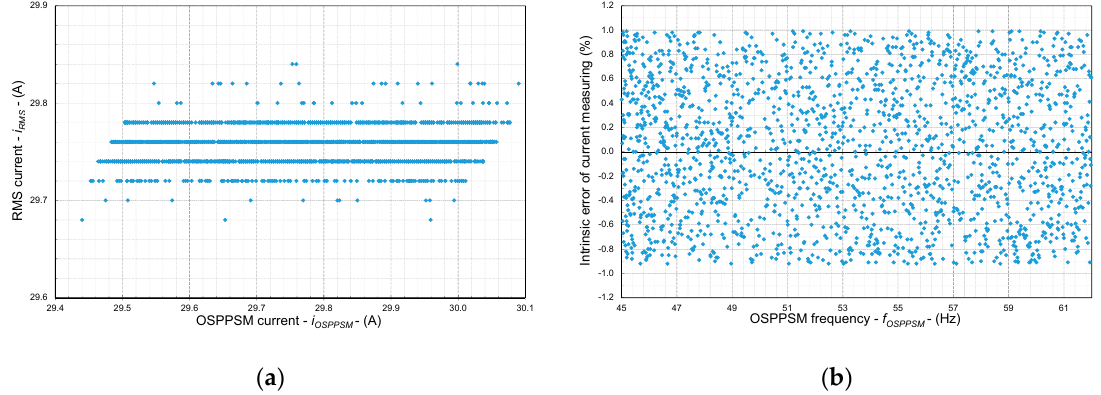
Figure 18. Ammeter test: ( a ) OSPPSM vs. RMS current. ( b ) Intrinsic error of current measuring.